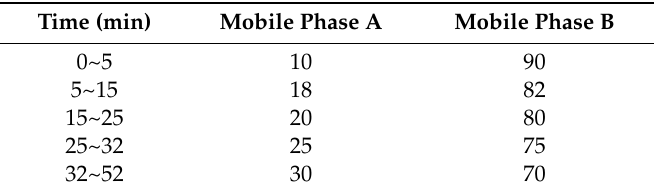
Table 1. Conditions of linear gradient elutions for flavonoids found in Astragalus mongolica. Time (min) Mobile Phase A Mobile Phase